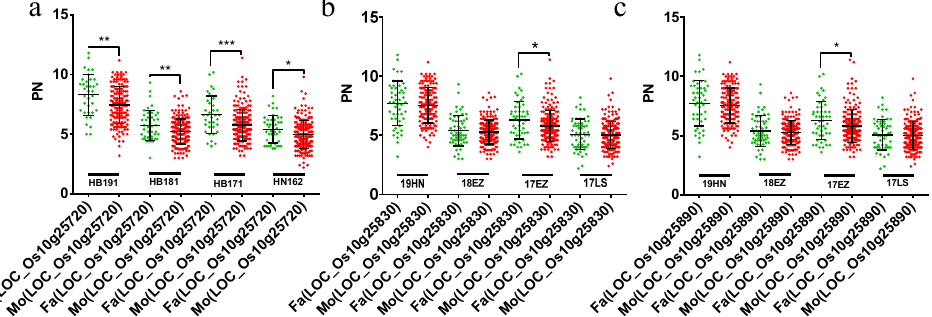
Figure 4. PN trait comparison of RILs with parental genotypes of LOC_10g25720 ( a ), LOC_10g25830 ( b ), and LOC_10g25890 ( c ) in multiple environments. RILs with the male parental genotype and female parental genotype of LOC_10g25720 , LOC_10g25830 , and LOC_10g25890 are marked by green dots and red dots in point clouds, respectively. * represents p < 0.05, ** represents p < 0.01, *** represents p < 0.001. PN: Effective panicle number.